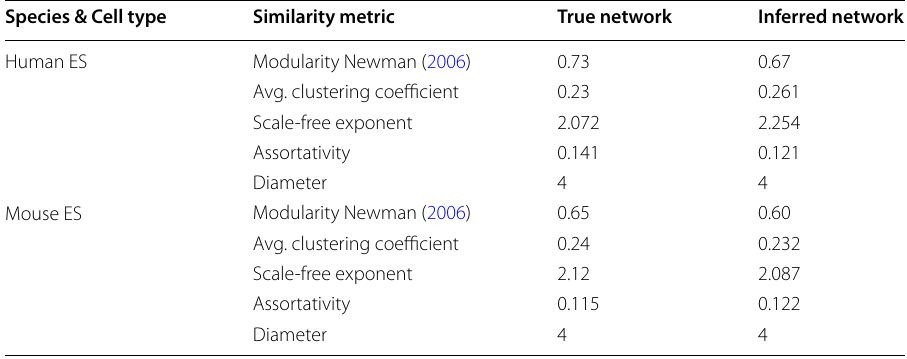
Table 2 Similarity metrics of true and inferred Hi–C interaction networks on chromosome 4 Species & Cell